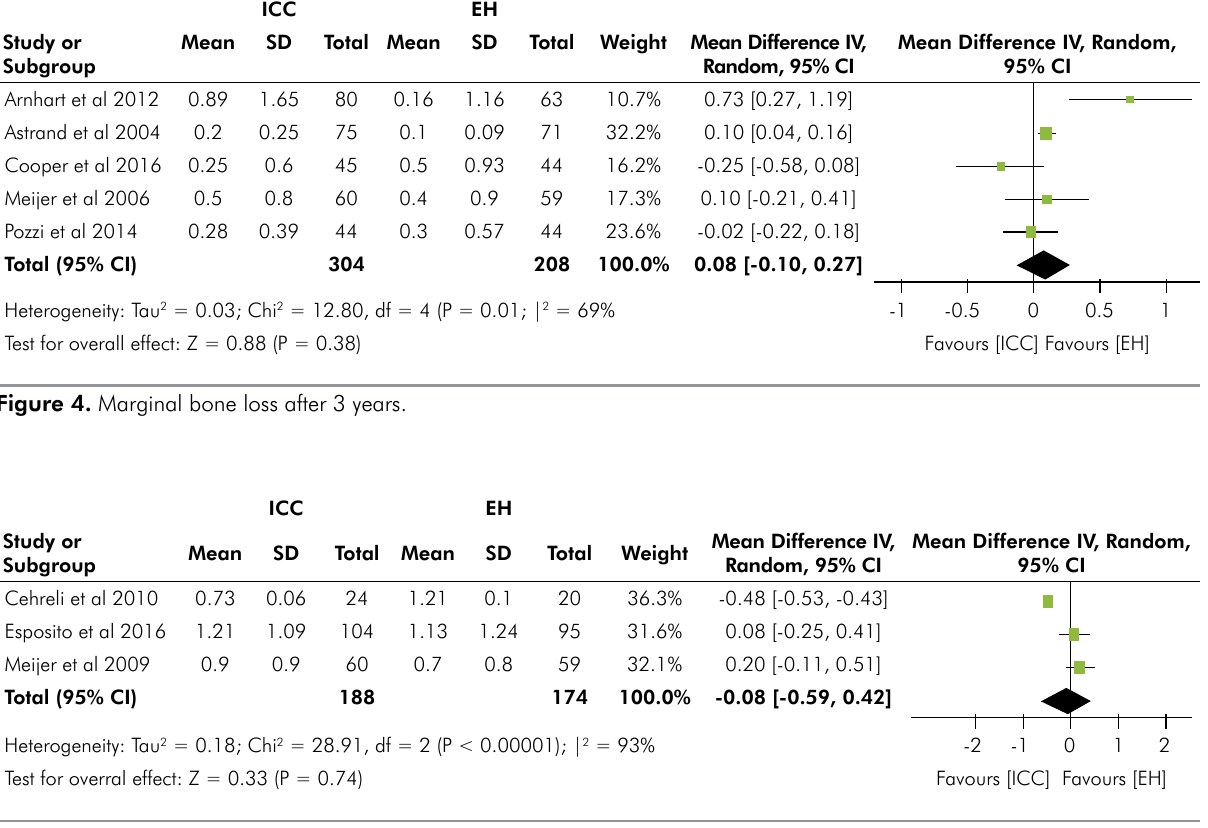
Figure 5. Marginal bone loss after 5